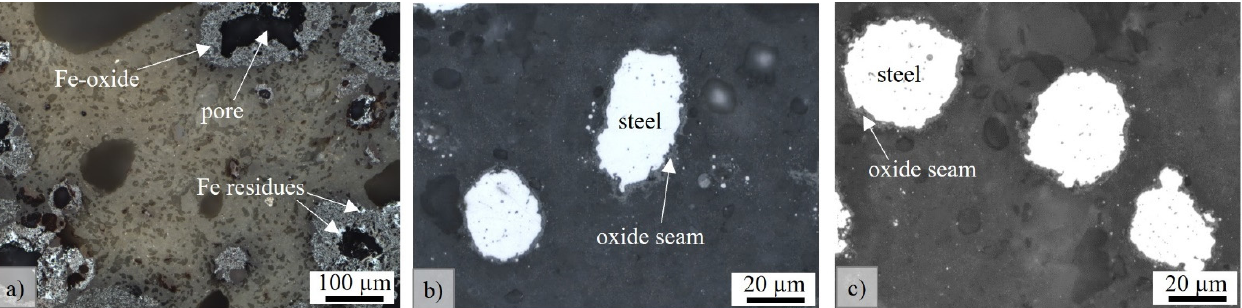
Figure 3. Light microscopic images of air-sintered composites consisting of clay with ( a ) iron particles or ( b , c ) 430L steel particles. Samples were dried and sintered immediately ( a , b ) or after 3 days ( c ).